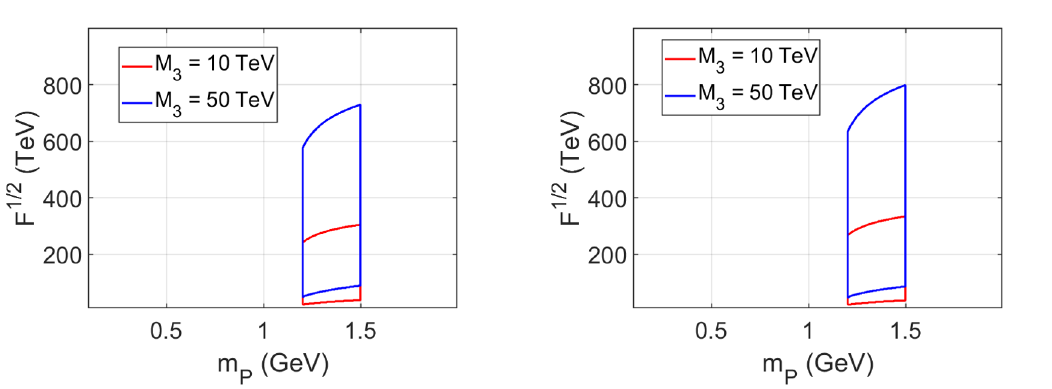
Figure 29 . Sensitivity regions of FASER-II to the model parameters, where pseudoscalar sgold- stinos are produced directly and then decay inside the detector volume into mesons. When only charged mesons are used as a signature, the regions are presented on left panel. The right panel shows the region, when both charged and neutral mesons are exploited as sgoldstino signatures. √ √ A Q = 100 GeV. In the regions where F < M 3 we set M 3 = F